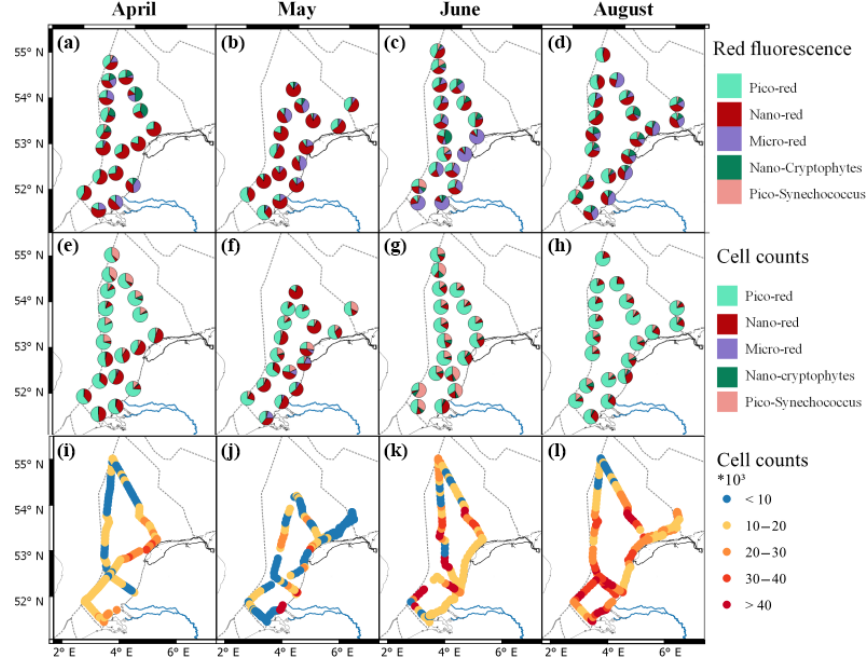
Figure 3. Relative phytoplankton community composition using FCM-derived total red fluorescence ( a–d ) and cell numbers ( e–h ) in April, May, June, and August (from left to right). The groups are clustered according to Table 2. Figure made with QGIS v2.14.2 using EEZ zone data from the Flanders Marine Institute